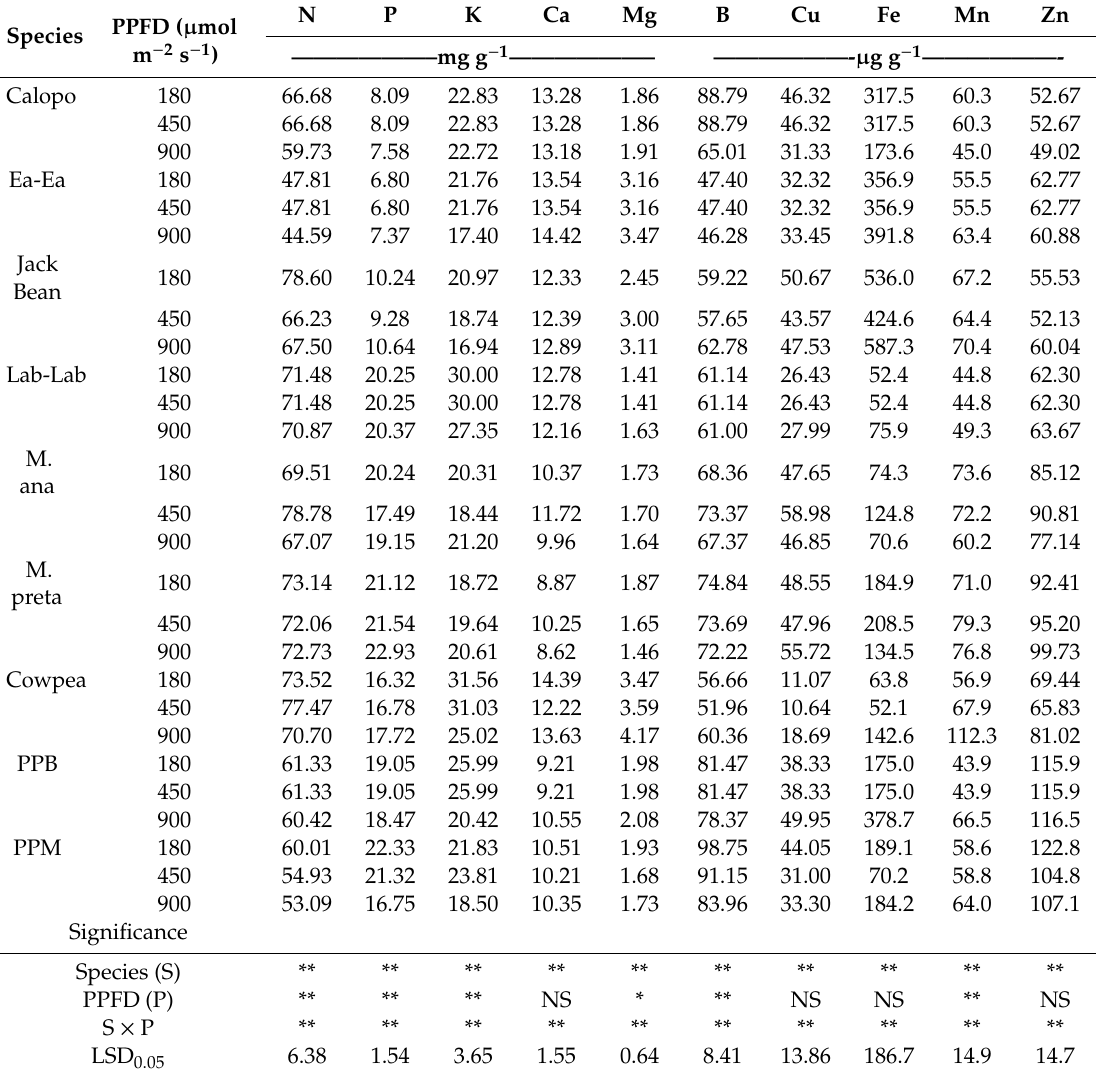
Table 5. E ff ect of photosynthetic photon flux density (PPFD) on plant nutrient concentrations in cover